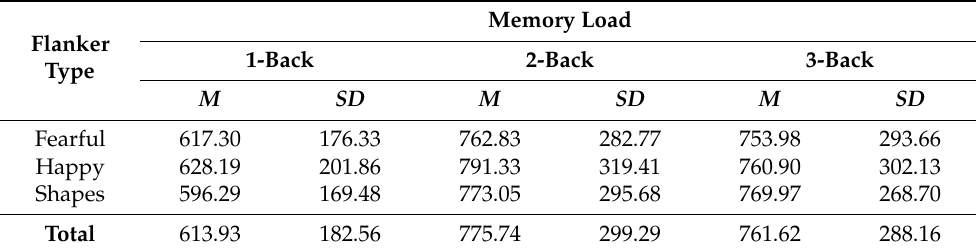
Table 11. Descriptive statistics of participants’ mean reaction times for correct rejections (before log-transformed) for all conditions in Study